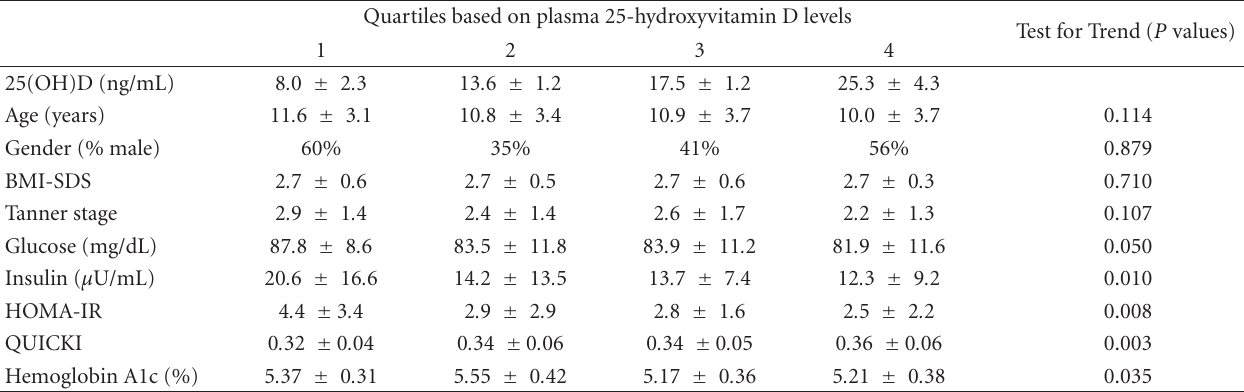
Table 1: Fasting glucose metabolism parameters in 125 obese children, in quartiles ( n = 30–32) of plasma 25-hydroxy vitamin D concentrations.